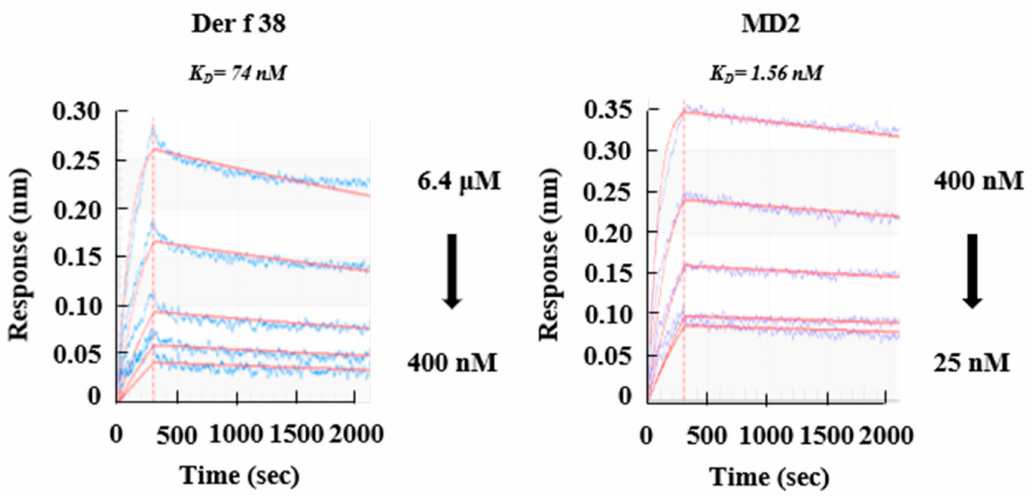
Figure 5. Der f 38 directly binds to TLR4. TLR4 was coated on an AR2G sensor chip. Binding affinities ( K D ) of Der f 38 and MD2 to TLR4 were measured by BLI as described in materials and methods.